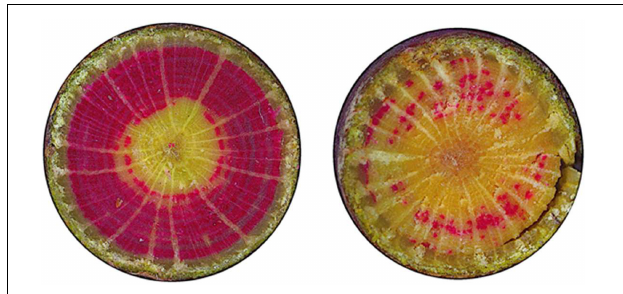
FIGURE 9 | Staining of active vessels of beech: examples of a beech with crown transparency of 20% (left) and 70% (right) .